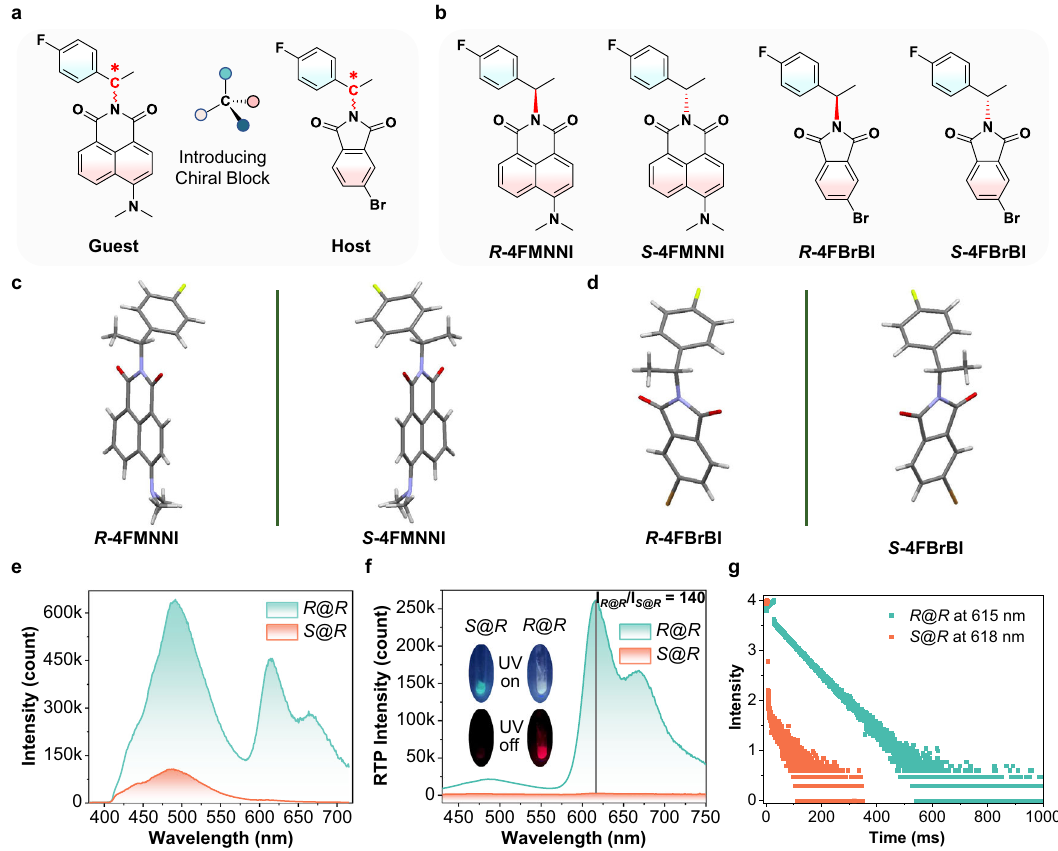
Fig. 1 | Chiral-selective RTP enhancement (CPE) with ep>10 2 . a Rational design ofchiralorganicphosphorsfordopedguest – hostRTPsystems.Thechiralaminoas chiralcarbonblockisintroducedtothenaphthalimideguestandphthalimidehost, the heavy-atom Br in the host promotes the ISC process and makes the host an excellent triplet energy donor. b Molecular structures of four chiral amino- modi fi ed compounds for constructing doped RTP systems. c Molecular con fi g- urations obtained from single-crystal X-ray diffraction (SC-XRD) for guests R − 4FMNNI and S − 4FMNNI . d SC-XRD structures for hosts R − 4FBrBI and S − 4FBrBI .